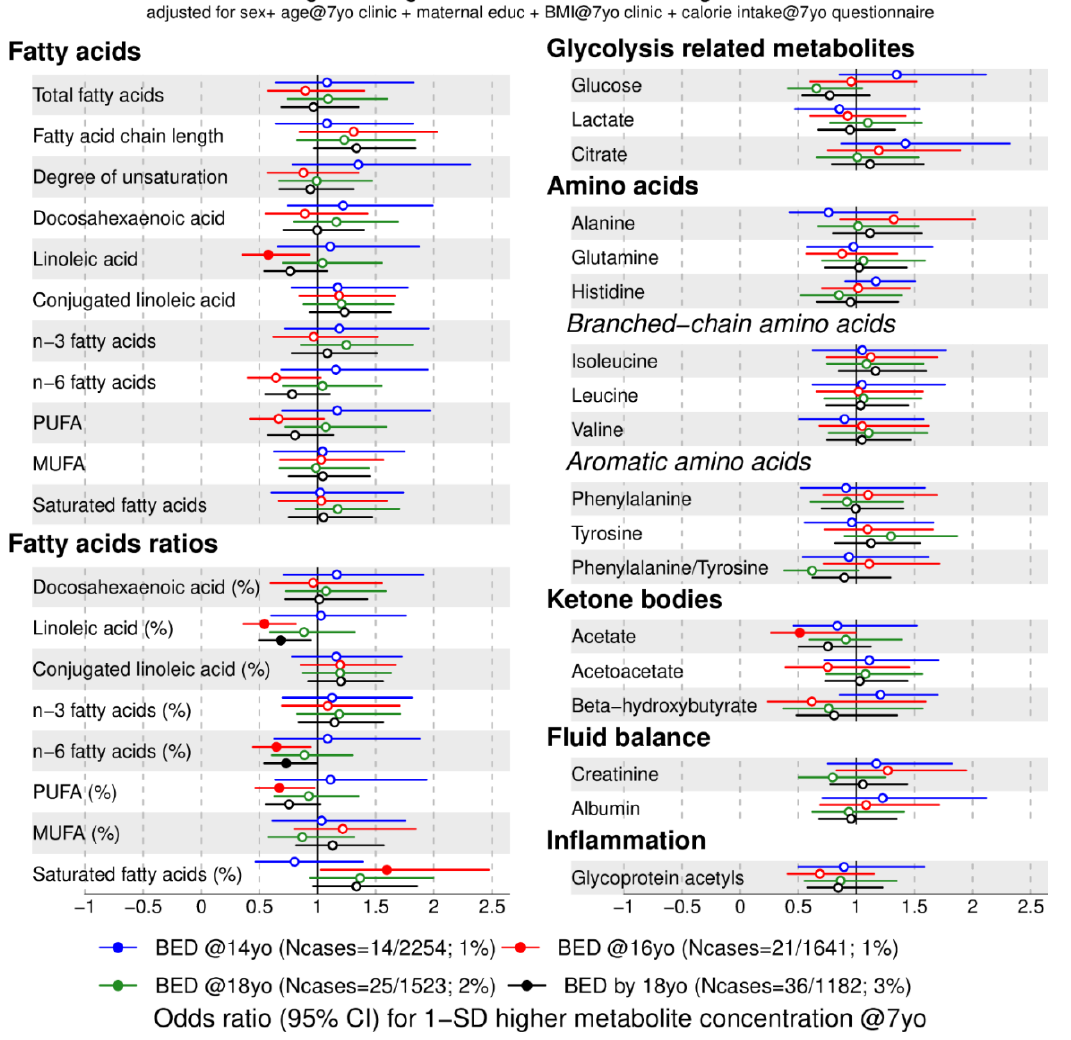
Figure 4. Estimated odds ratios for binge-eating disorder at 14, 16, 18 years of age and cumulatively across all three time points according to lipid- and non-lipid-related metabolic trait concentrations at 7 years (Figure 3 continued). Estimates refer to 1 standard deviation increase in metabolic trait concentration at 7 years. Error bars = 95% confidence intervals (CI). Abbreviations: BED = binge-eating disorder; MUFA = monounsaturated fatty acids; PUFA = polyunsaturated fatty acids. Note: Filled dot: CI do not include the null. MUFA, PUFA and saturated fatty acid concentrations include all fatty acids detected which have one, more than one, or zero C = C double bonds in their backbone, respectively.